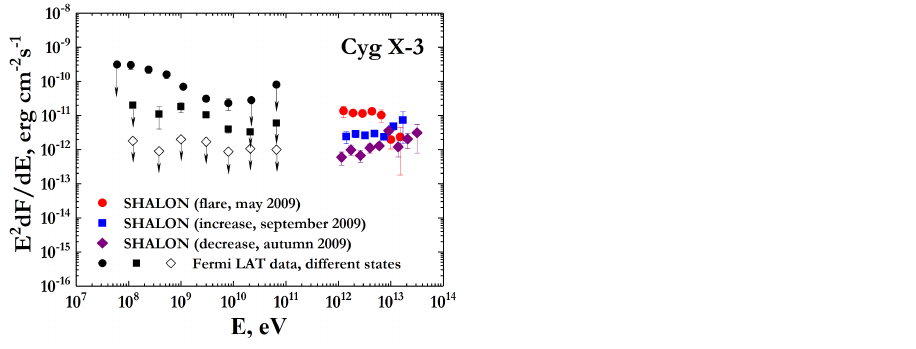
Figure 8. Spectral energy distribution of the γ -ray emission from Cyg X-3 during the flux increases and decrease in 2009 compared with Fermi LAT fluxes refer to different states (see text).